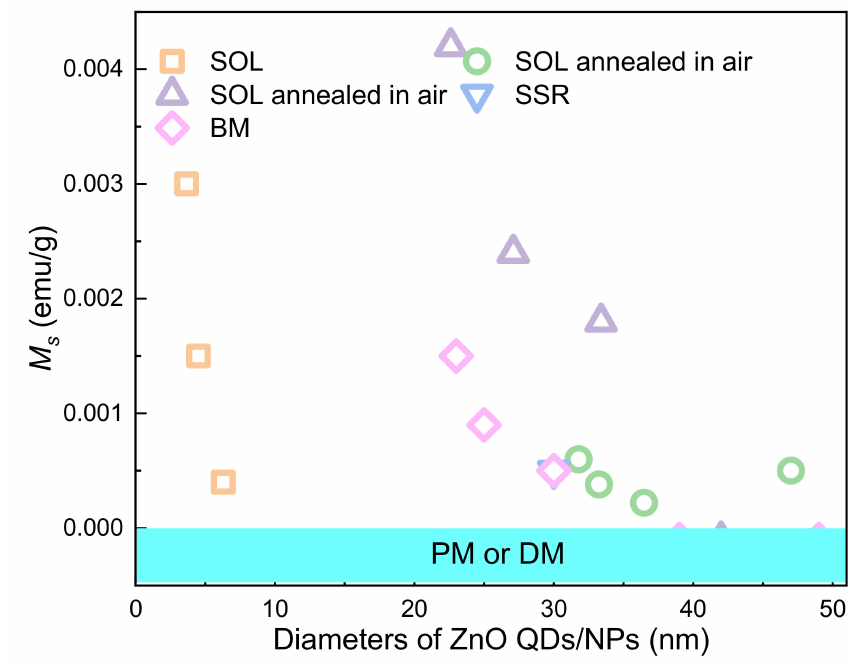
Figure 3. The size-dependent RTFM in ZnO